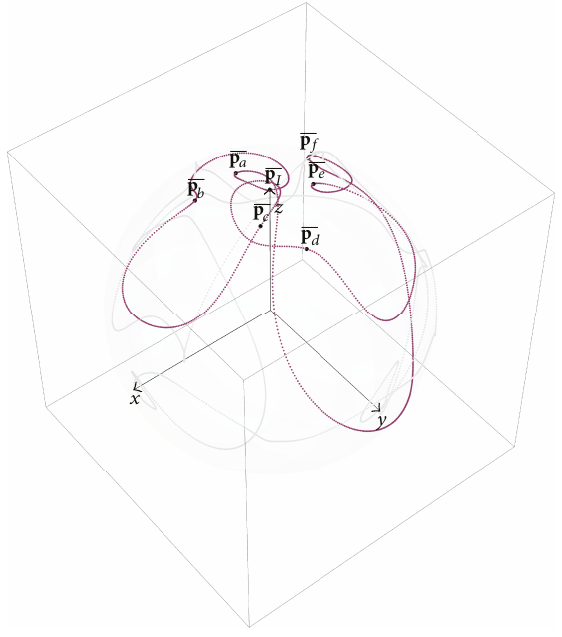
Figure 2: Motion of the body frame of the spacecraft in experiment A with 6 target attitudes. The traces of the x - and y -axes on the unit sphere are represented in grey, whereas the trace of the z -axis is represented in